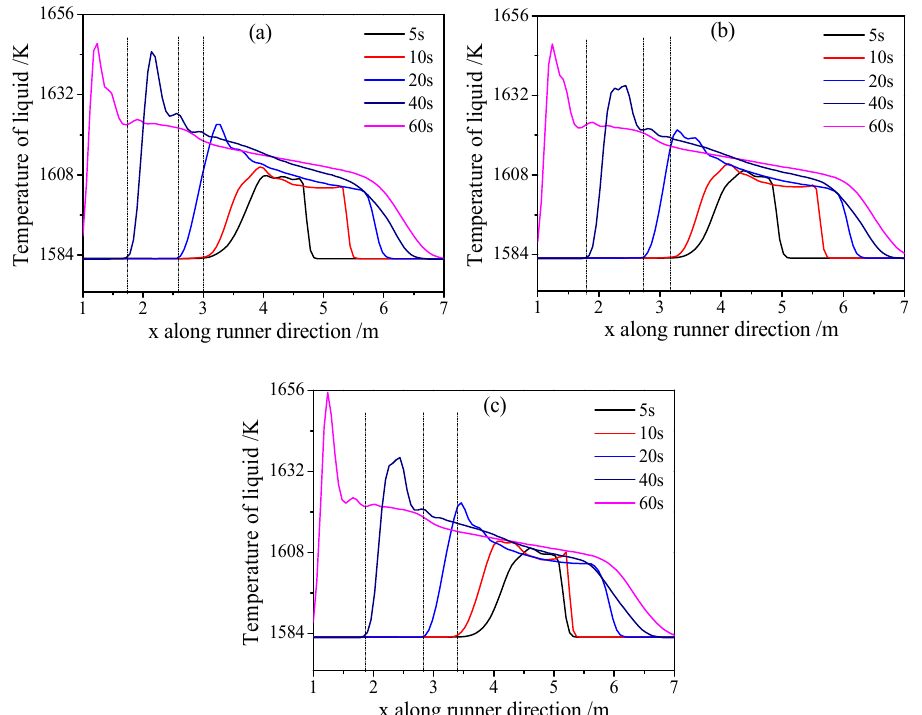
Figure 13. Temperature fluctuations on line 3 (cf. Figure 3b) during tapping with different tap hole angles, ( a ) 7°, ( b ) 10° and ( c ) 12°.